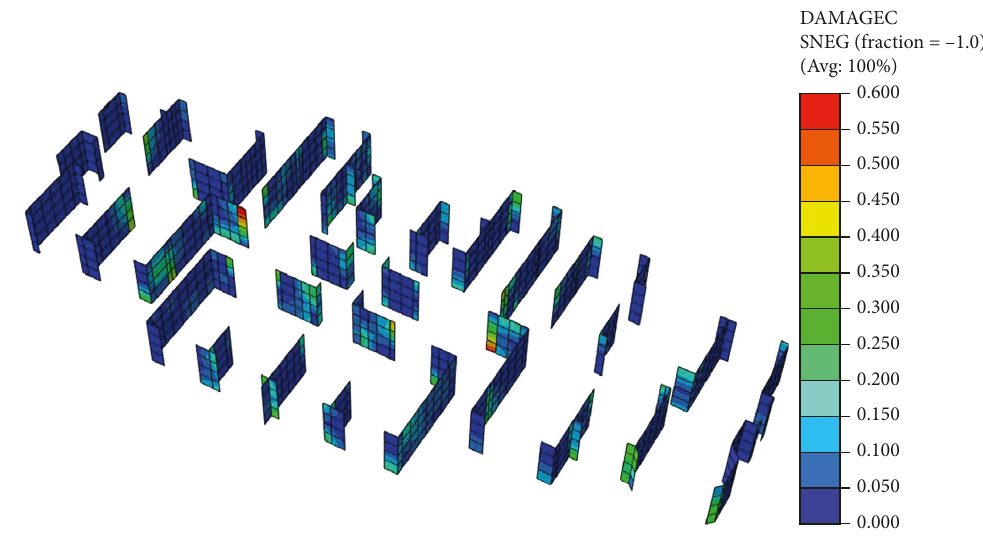
Figure 4: Concrete compressive damage of vertical shear walls in the key floor.